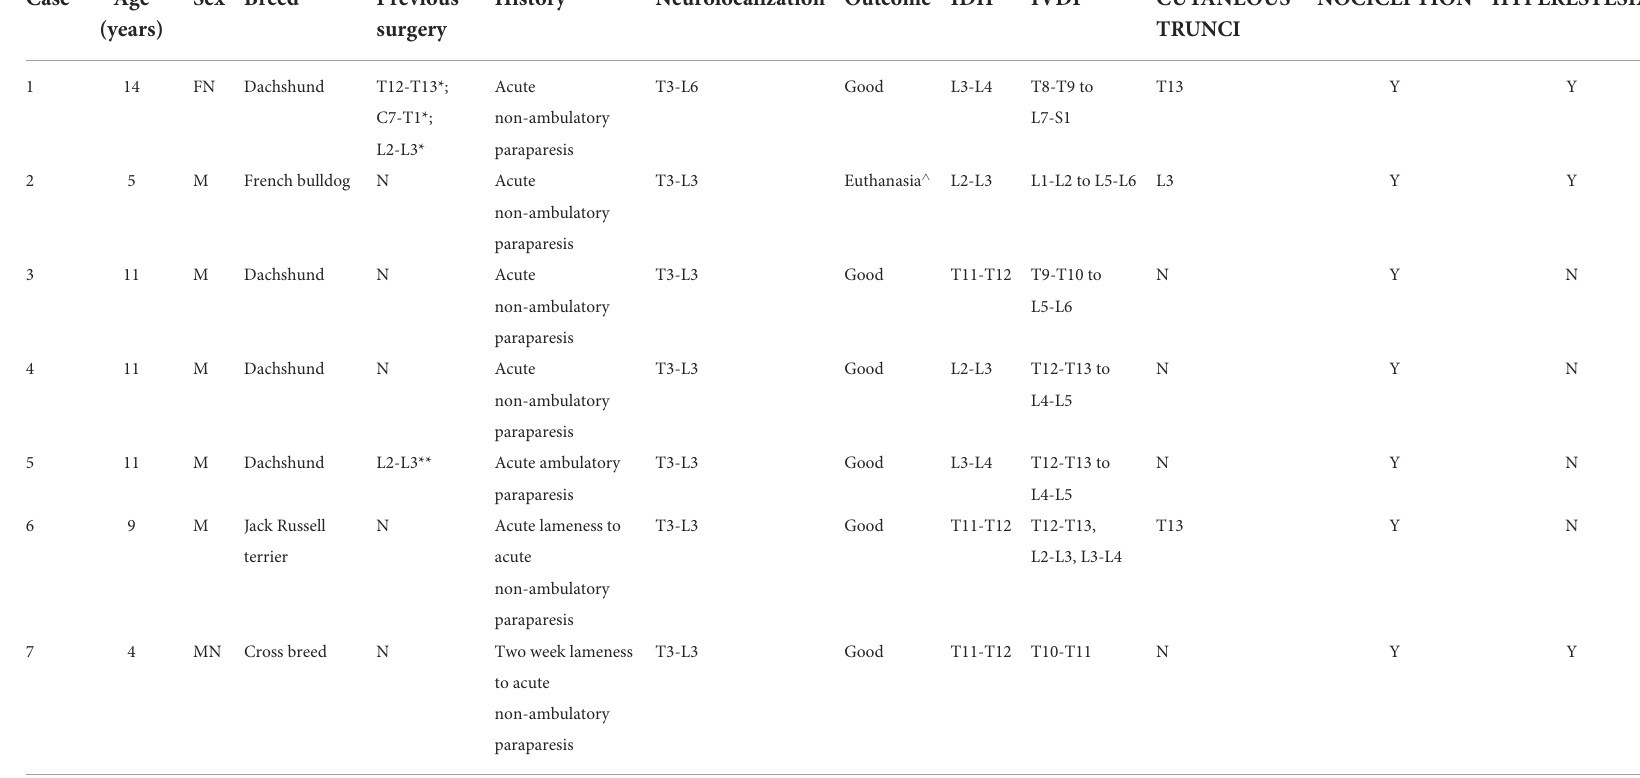
TABLE 1 Clinical characteristics of seven dogs with confirmed thoracolumbar intradural disc